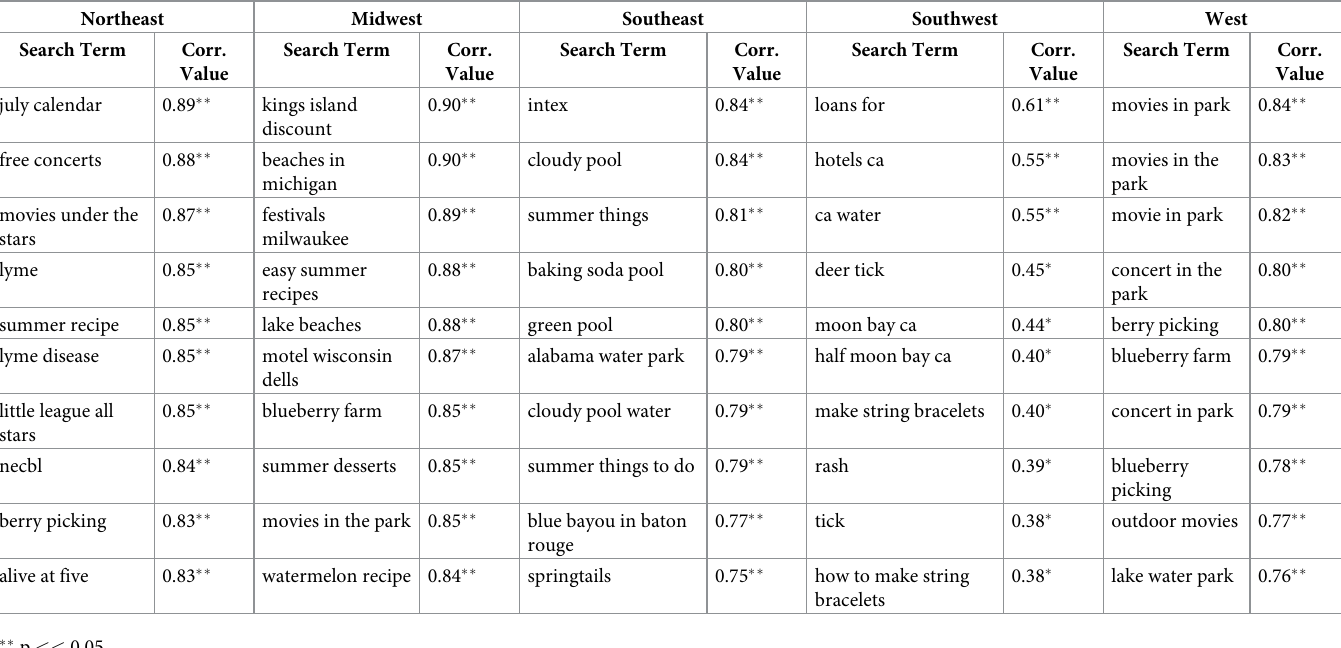
Table 4. Ten most correlated regional search terms for training period (2004–2012).